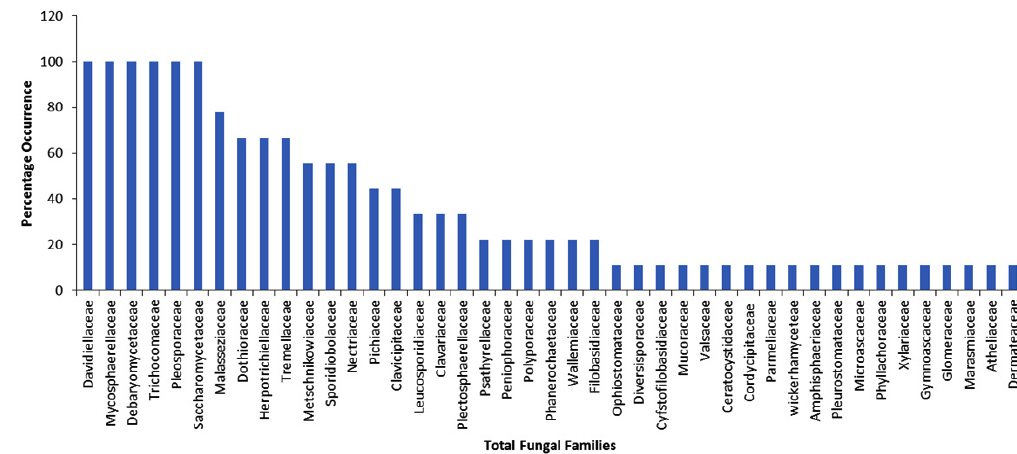
Fig. 3. Percentage occurrence of each fungal family identified in the polyherbal remedy